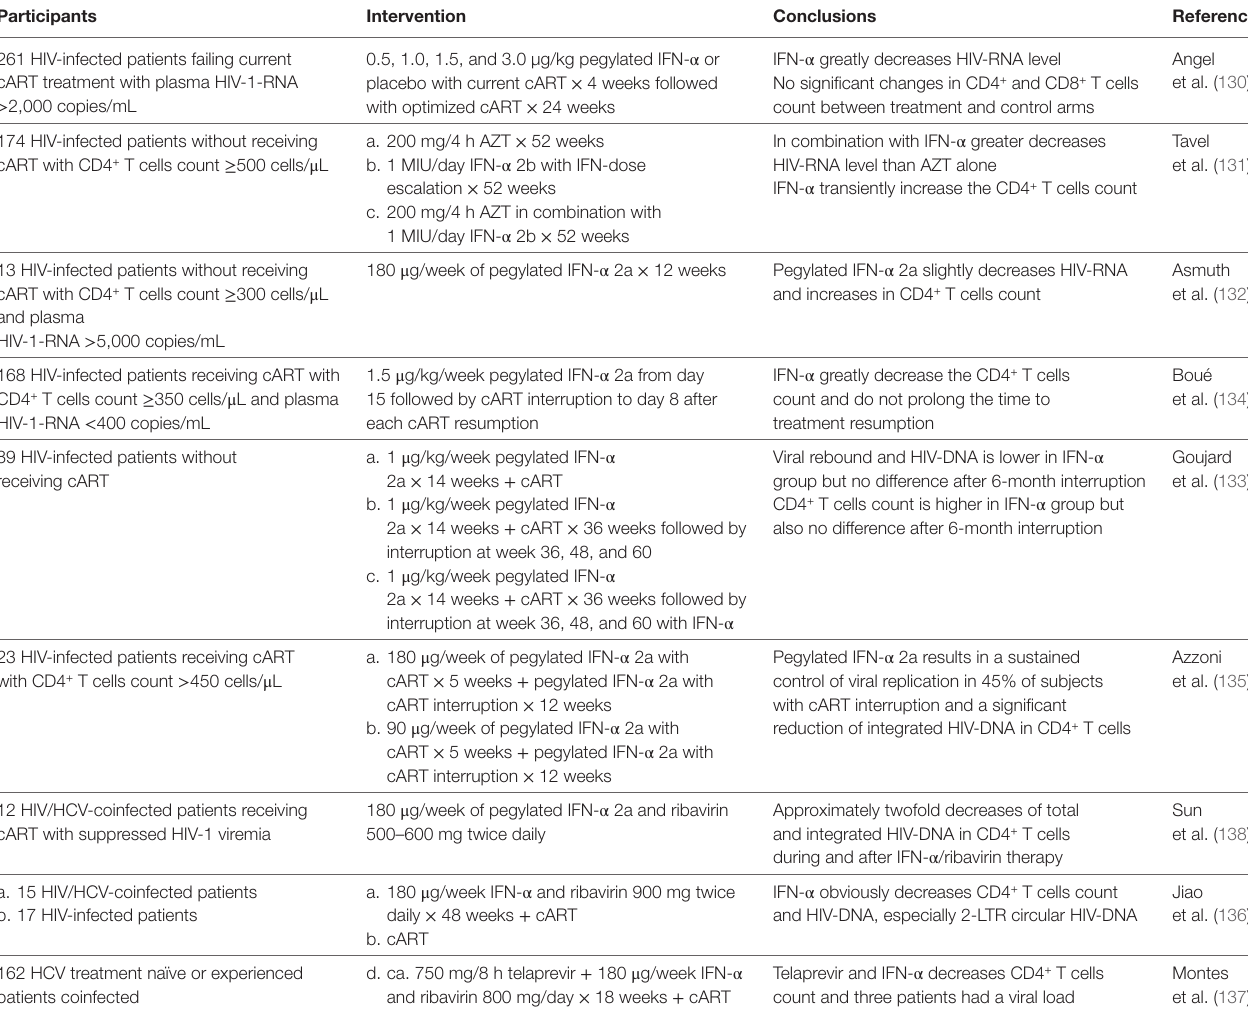
Table 1 | Studies of IFN-I administration in